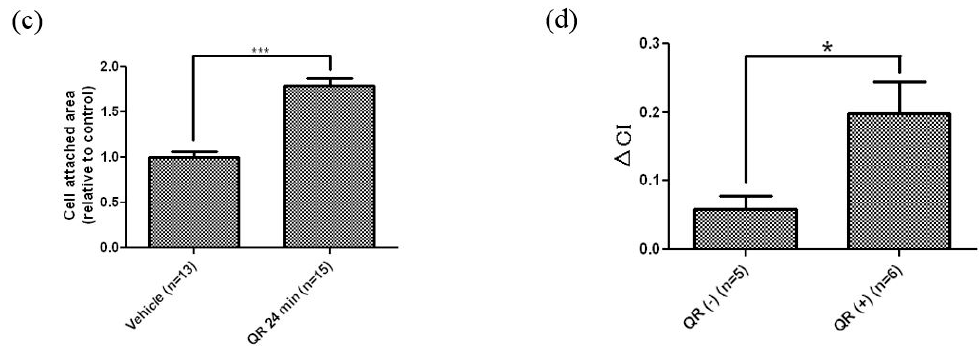
Figure 5. ( a ) Real-time monitoring of CI of RBL-48 cells treated with serum from donor 1 with or without stimulation (RBL-48 cells in 194 μ L suspension and 6 μ L human serum per well). Δ CI of cells increased in response to anti-IgE or QR. Maximum changes were observed around 24 min after the stimulation. ( b , c ) Horizontal spreading of RBL-48 cells in response to QR. The white bar shows ca. 10 μ m. Cell area was measured by Image Pro. ‘n’ means number of cells measured. ( d ) Average CI change ( Δ CI) of RBL-48 cells treated with serum of QR-positive and that with serum of QR-negative patient in response to QR (*; <0.05). Error bars represent standard error.